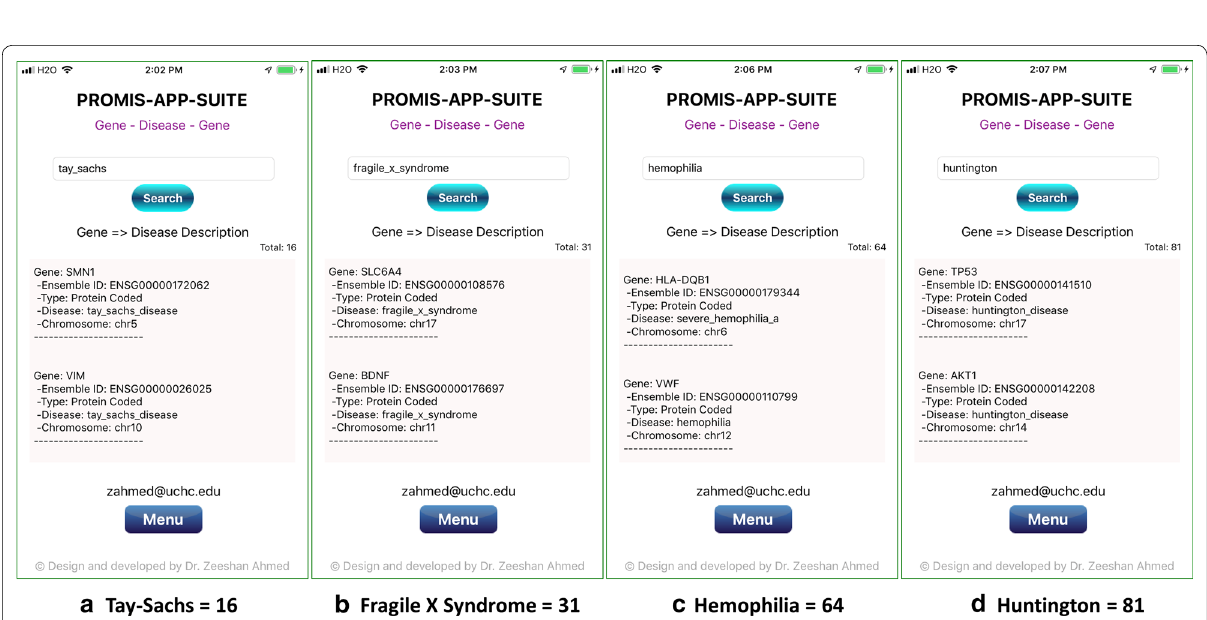
Fig. 6 PAS-Gen screenshots examples of gene results (top two shown) for searches of common genetic diseases: a 16 results for Tay-Sachs disease, b 31 results for Fragile X Syndrome, c 64 results for Hemophilia, and d 81 results for Huntington. Detailed results are attached in Additional file